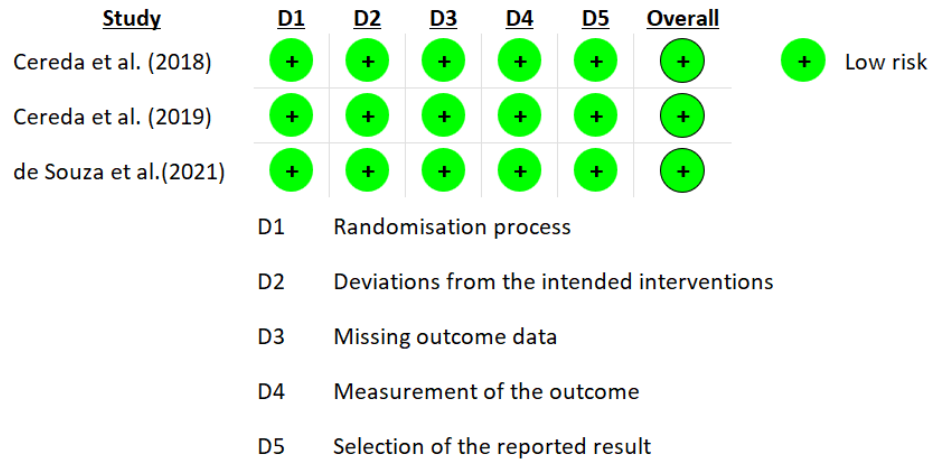
Figure 3. Graph of RoB 2.0 for each study according to the five domains defined by Cochrane for intention to treat studies [39,40,55].